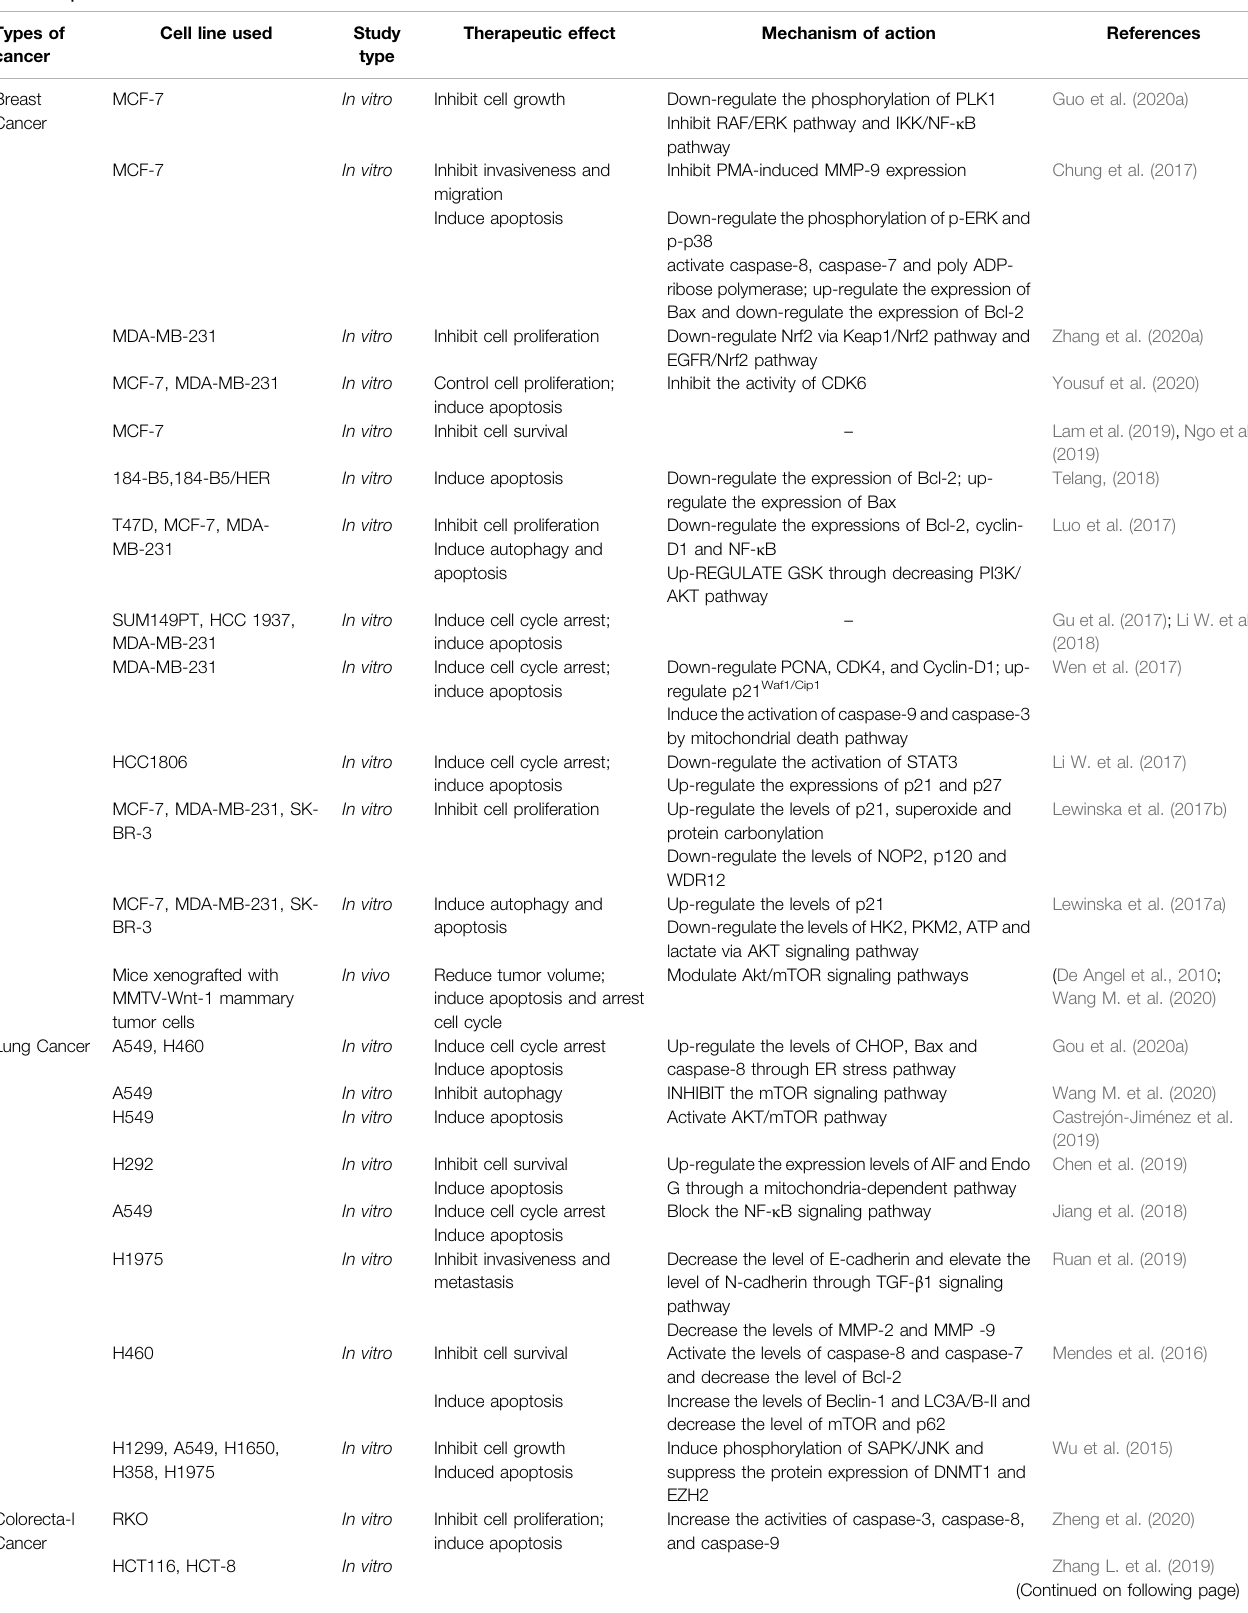
TABLE 1 | The detailed role of UA and cancer. Types of